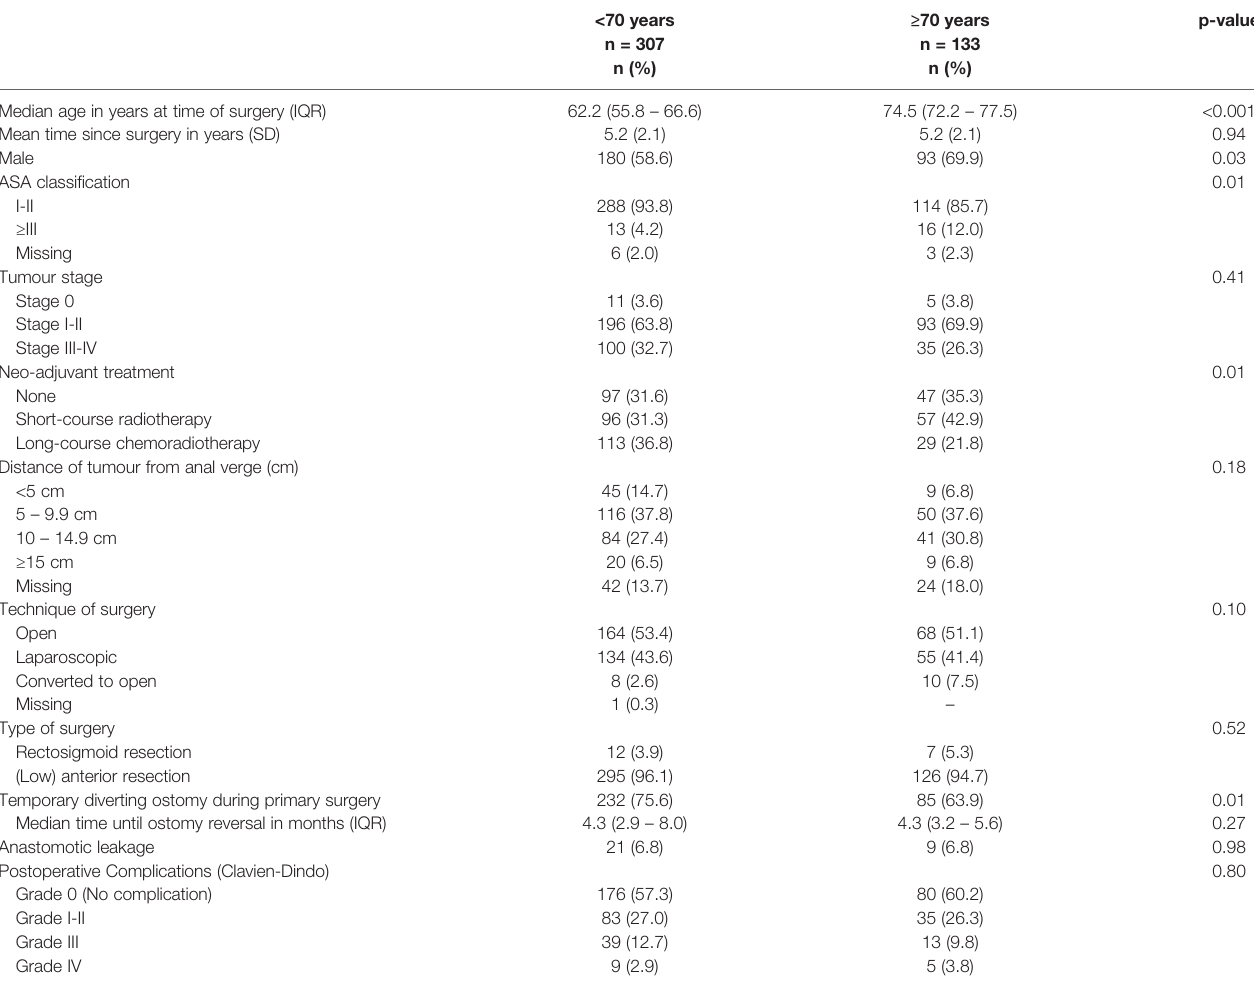
TABLE 1 | Demographic, clinical and tumour characteristics of rectal cancer patients (n=440), strati fi ed by age groups (<70 years and ≥ 70